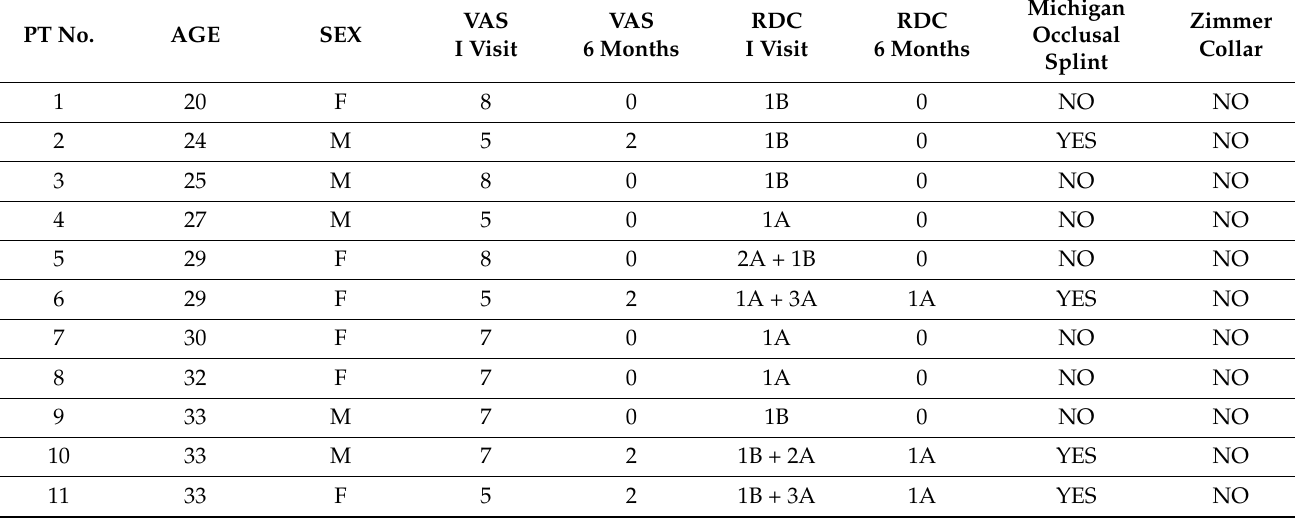
Table 3. Control group results (Zimmer collar